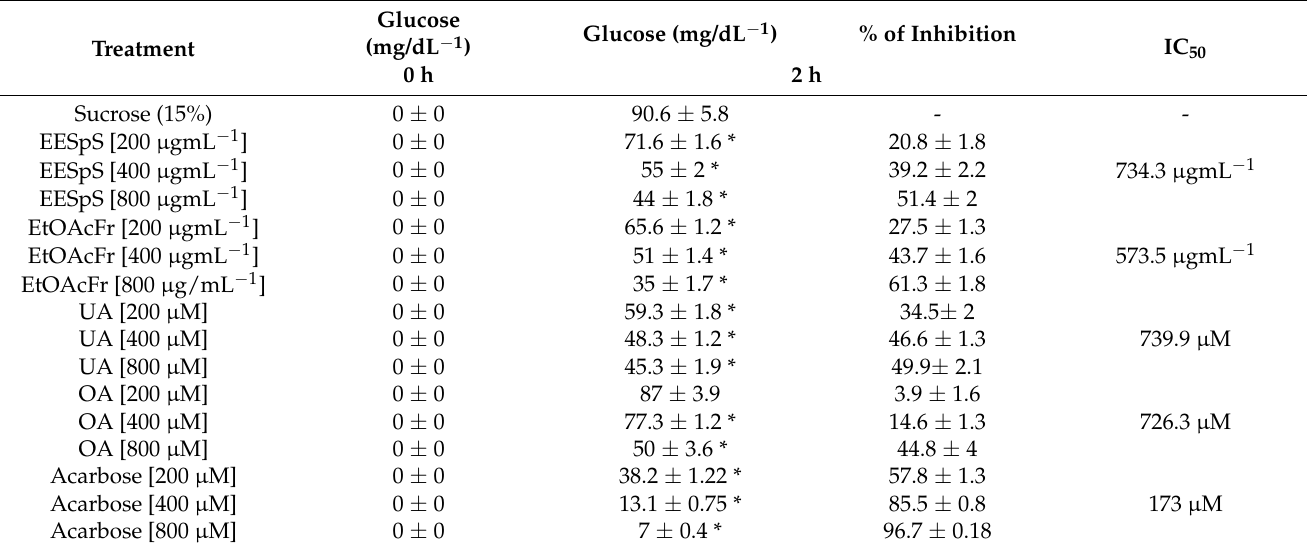
Table 3. Quantity of glucose measured in the external aqueous medium, percent inhibition, and CE 50 calculated after addition of treatments on intestinal sucrose hydrolysis (ISH) inhibition test.